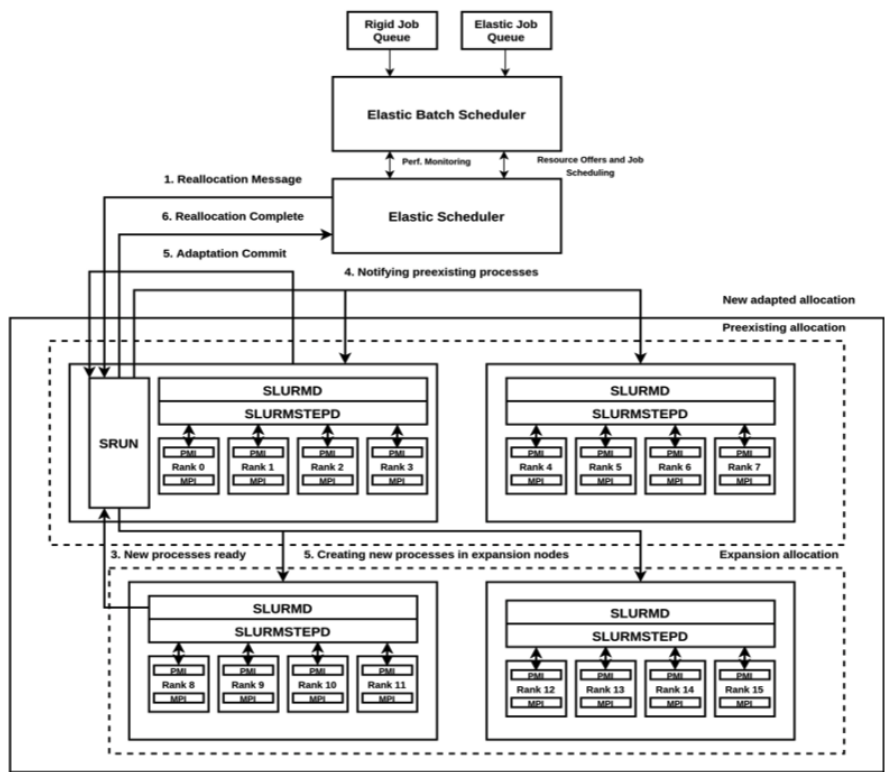
Figure 3. Elastic MPI—overview of interactions between different SLURM daemons during a reconfig- uration with the elastic execution [21]. Source: